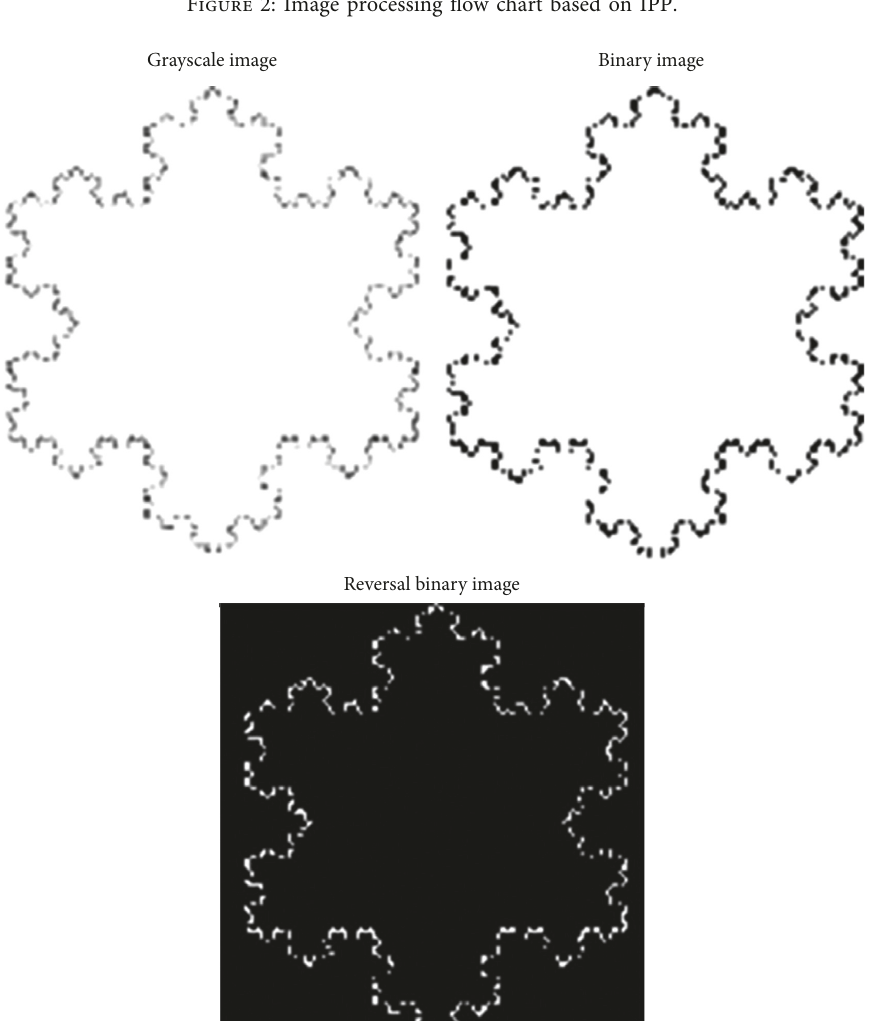
Figure 3: Koch curve image binarization